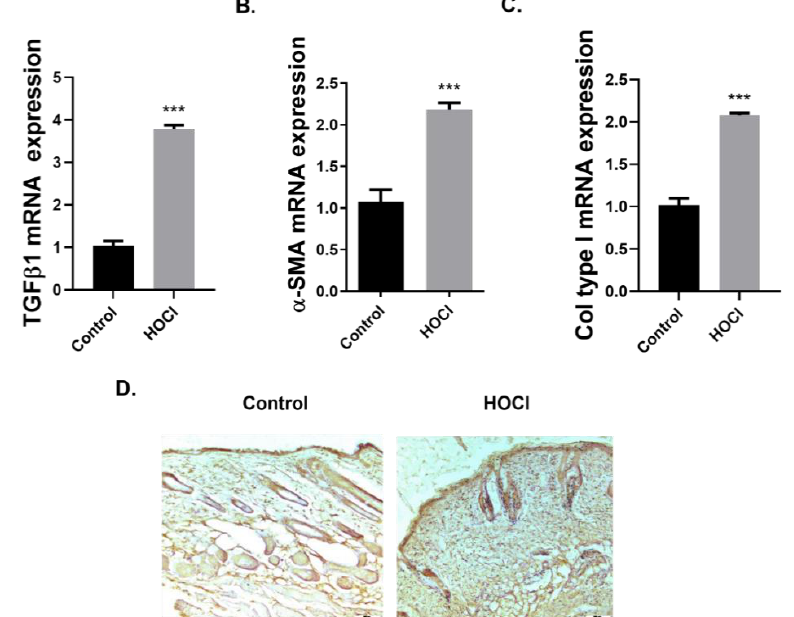
Figure 3. Skin fibrosis animal model. BALB/c mice were administered intra-dermal injections of 100 µ L hypochlorite (HOCl) daily for 6 weeks. Mice were culled and levels of ( A ) Transforming growth factor β 1 (TGF β 1), ( B ) alpha smooth muscle actin ( α -SMA) and ( C ) collagen type I (Col type I) messenger RNA in fibrotic skin tissue were assessed by real-time PCR. Fibrotic skin tissue was embedded in paraffin and ( D ) α -SMA immunohistochemistry was performed. The graphs present data from one experiment with n = 7 (Control) and n = 8 (HOCl) mice per group. Results are presented as mean ± SEM. Statistical analysis was performed with two-tailed Student’s unpaired t-test for independent samples. *** p < 0.001 vs. control. Original magnification: × 10; Scale 200 µ